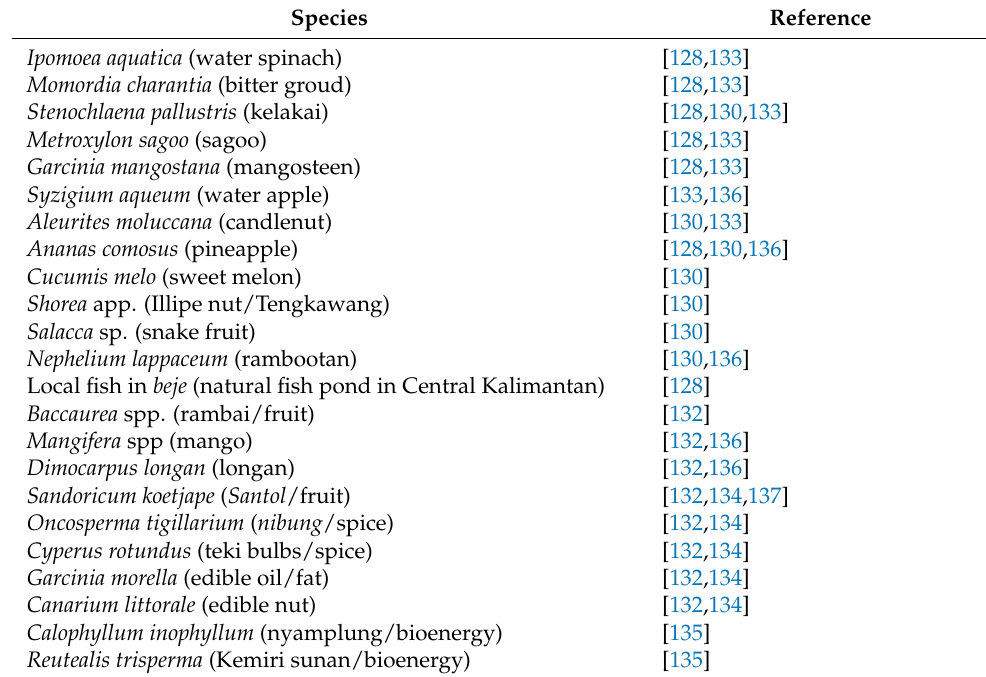
Table 2. The paludiculture species found in Indonesian tropical